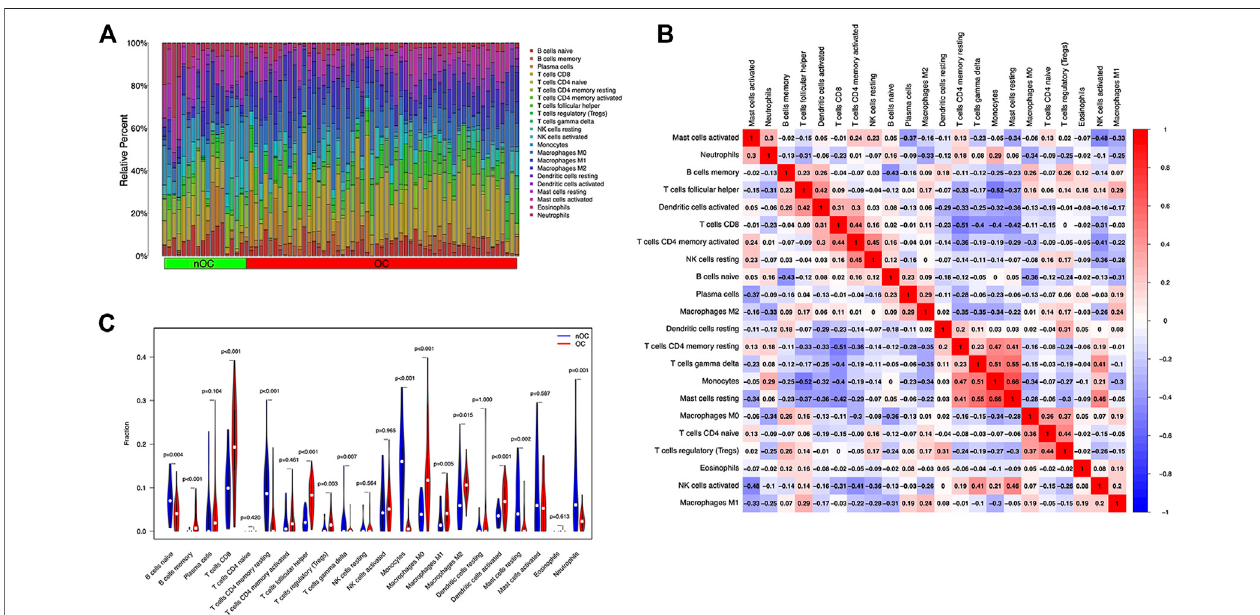
FIGURE7| Immunecellin fi ltrationanalysisinthetrainingset. (A) Thegraphshowsthelevelofin fi ltrationofdifferentimmunecellsbetweentheovariancancergroup and the non-ovarian cancer group. (B) The violin chart shows the different analyses of immune cells. The abscissa indicates the name of immune cells, the ordinate indicatesthecontentofimmunecells,blueindicatesthecontrolgroup,andredindicatestheovariancancergroup. p < 0.05indicatesthatthereisasigni fi cantdifference in the content of immune cells between the two groups. (C) Correlation analysis between immune cells. Both the abscissa and the ordinate are the names of immune cells, and the value indicates the correlation coef fi cient between immune cells. Red indicates positive correlation, and blue indicates negative correlation. The two immune cells associated with the red grid, the higher the level of one immune cell, the higher the level of the other immune cell. The higher the level of one of the two immune cells associated with the blue grid, the lower the level of the other immune cell.